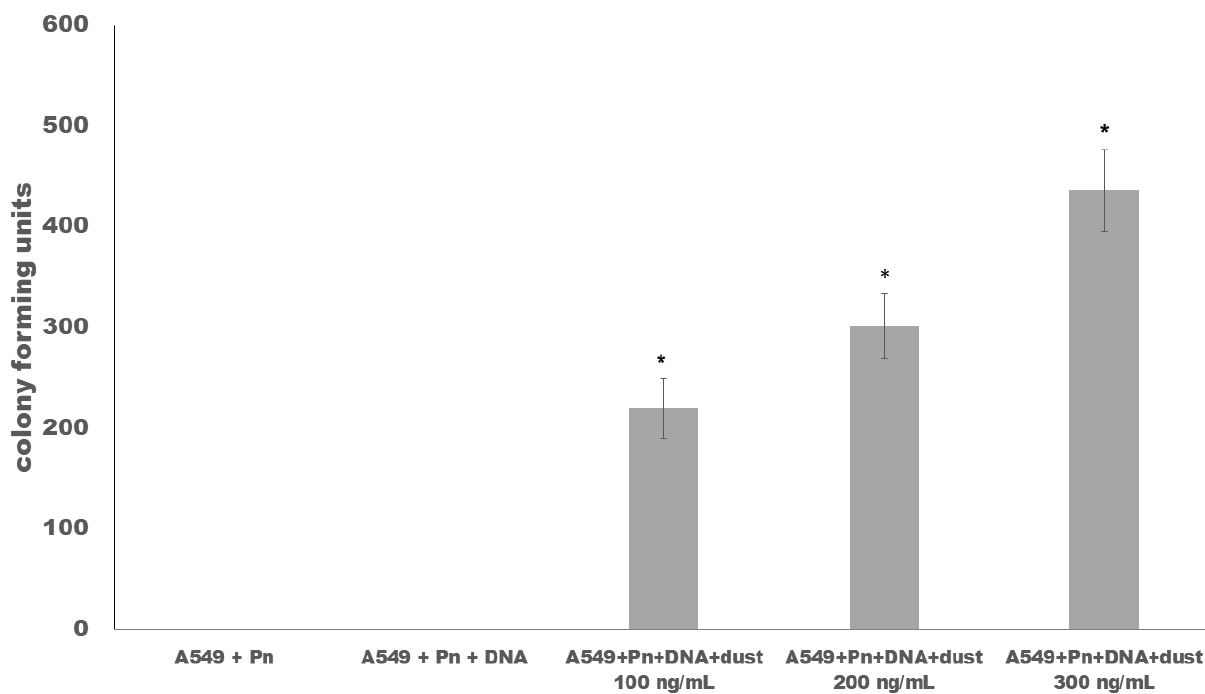
Figure 3 – The use of a system mimicking the respiratory tract by A549 cells use (adenocarcinoma from lung) and its action in pneumococci transformation. The colony forming units obtained from the test where the pneumococci cells were exposed to A549 cells microenvironment and environmental dust in a Brazilian region where the burning of sugar cane is a practice in the agricultural management. All concentrations of dust (100, 200 and 300 ng/mL) were capable to increase the transformation capacity of pneumococci cells in contact with A549 microenvironment. *All the values showed significant results when compared with control sample (p values